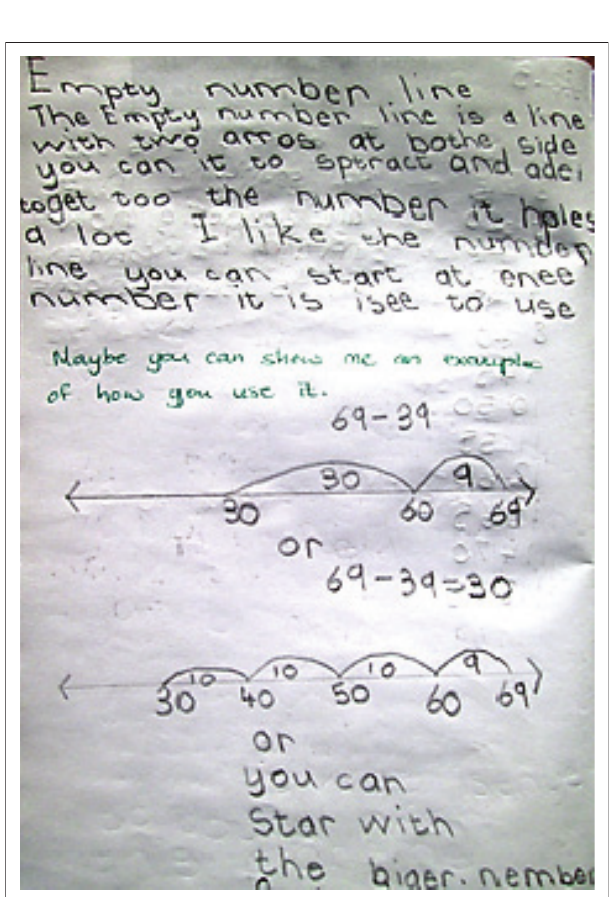
FIGURE 2: Bevan (Explanation).